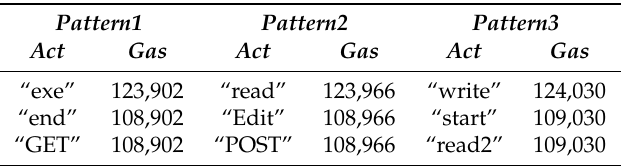
Table 4. Gas Used in createAction()